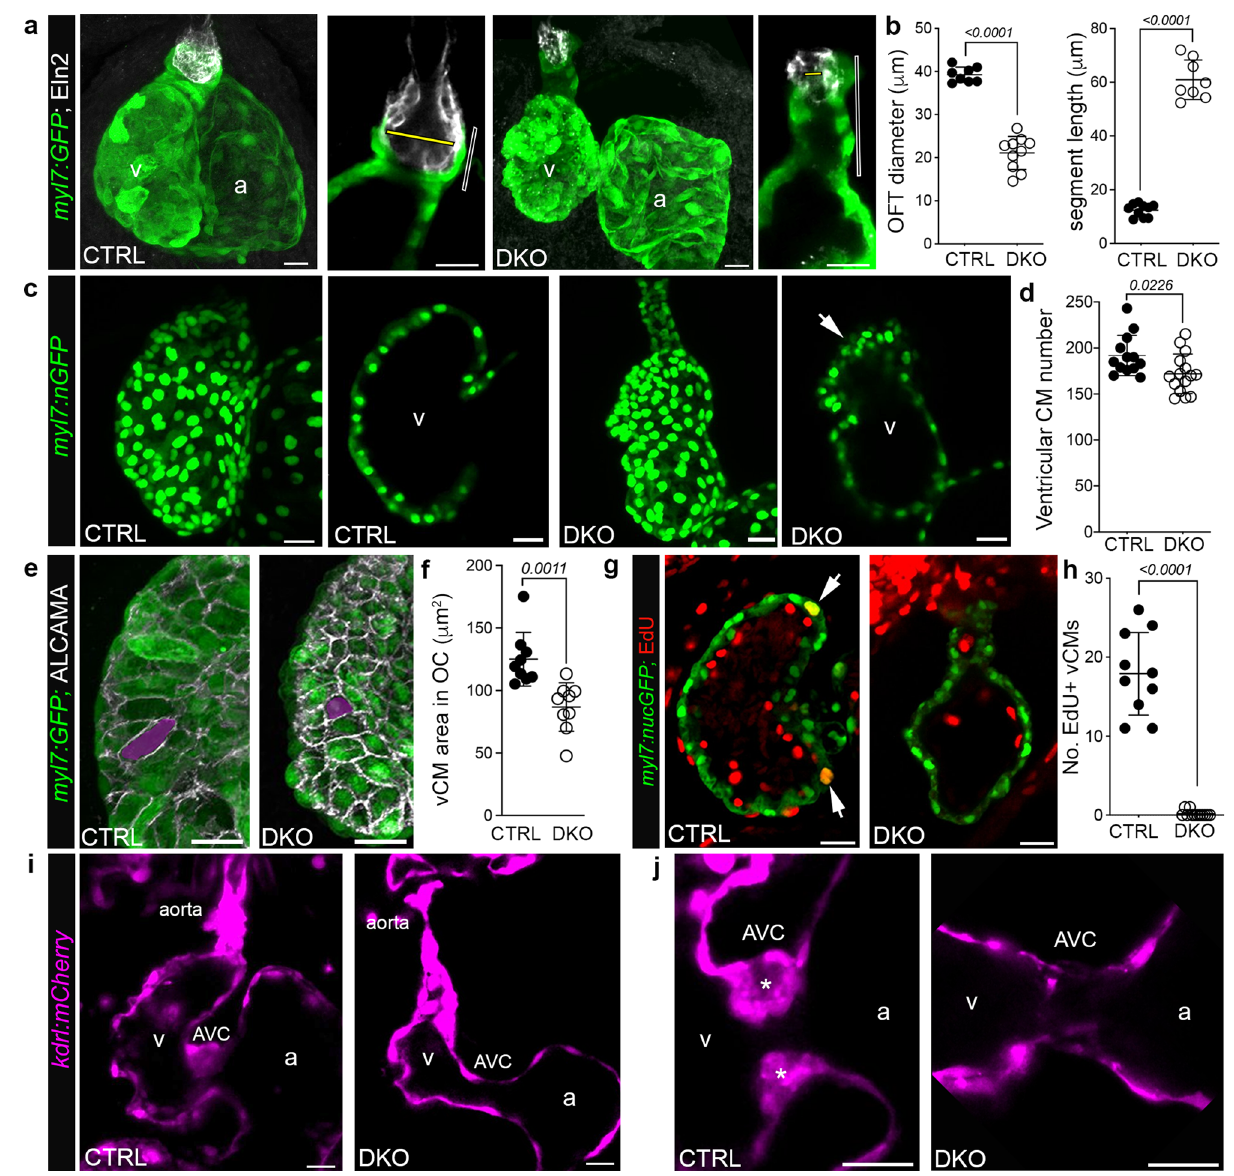
Fig. 2 | Rbfox -de fi cient zebra fi sh display cardiovascular defects overlapping those in HLHS hearts. a Confocal z-stacks or single optical sections of hearts or OFTs from 72hpf CTRL or DKO embryos carrying the Tg( myl7:GFP) reporter fol- lowingimmunostainingforGFP(green)andElastin2(Eln2;white).Yellowbars,OFT diameter. Open bars, myocardial segment length. b Dot plots showing OFT dia- meterandmyocardialsegmentlength. c Confocalz-stacksorsingleopticalsections of hearts from 72hpf CTRL and DKO embryos carrying the Tg ( myl7:nGFP) trans- gene following immunostaining for GFP (green). Arrow highlights myocardial dis- organization in the DKO ventricle. d Dot plot of ventricular cardiomyocyte numbers. e Confocal z-stacks of the ventricular OC from 72hpf CTRL and DKO embryos carrying the Tg(myl7:GFP) reporter following immunostaining for GFP (green) and ALCAMA (white). Magenta overlay shows the area of a representative OC cardiomyocyte. f Dot plot showing the average area of ventricular OC